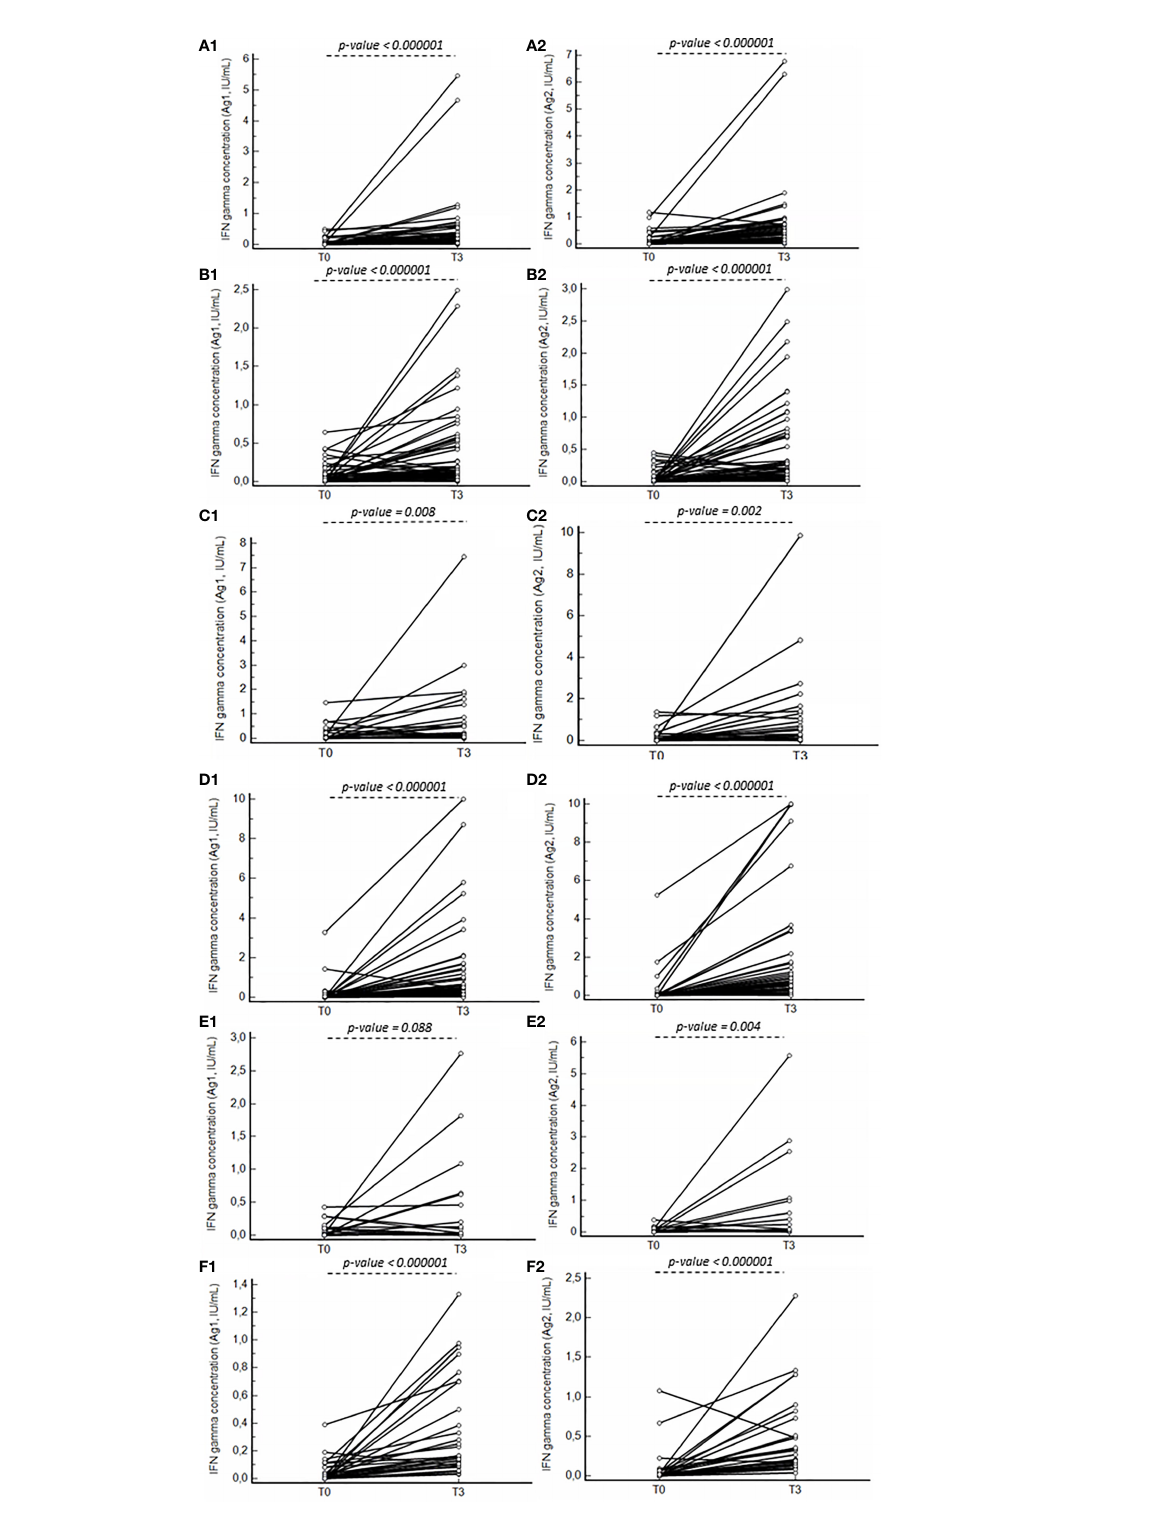
FIGURE 2 | Line graphs presenting the difference in IFN gamma concentration for Ag1 (1) and Ag2 (2) between T0 and T3 for the healthy control group (A) , primary immunode fi ciency patients (B) , PLWH (C) , neurology (D) , rheumatology (E) and CKD (F) patient groups. P-values indicating signi fi cant differences between the median concentrations are